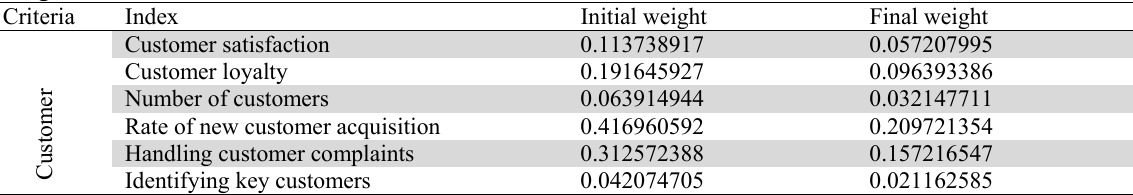
Weights for customer criteria